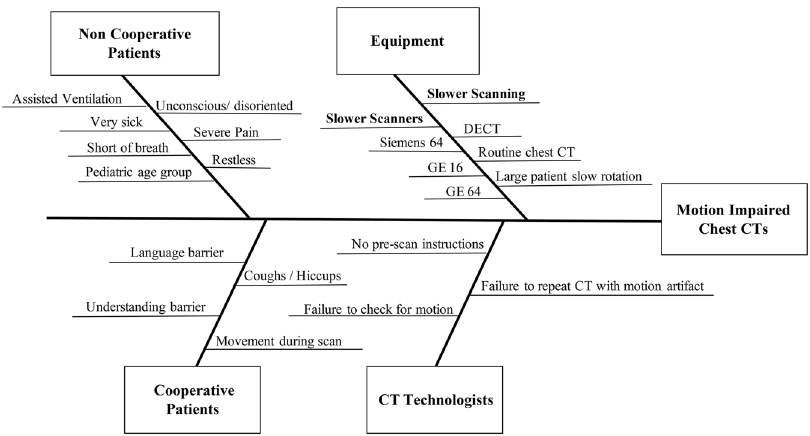
Figure 2. Ishikawa Fishbone Diagram. The cause and effect diagram for motion impaired and expiratory phase chest CT